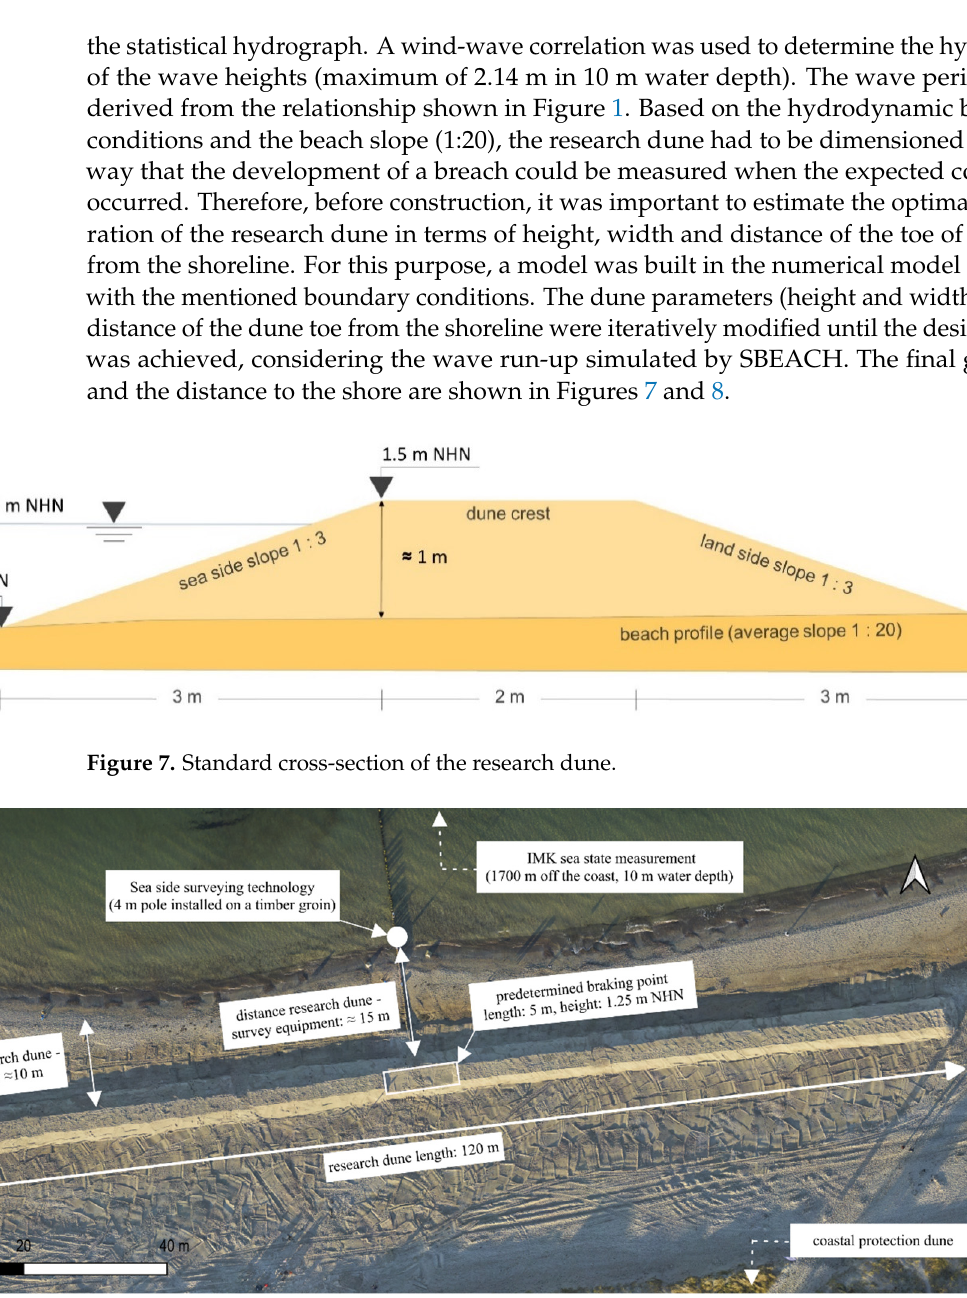
Figure 8. Research dune from above with a predetermined breaking point in the middle ([35] mod- ified; Photo: M. Naumann).